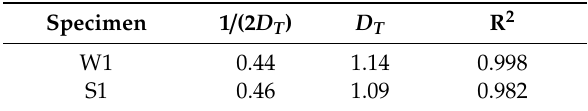
Figure 5. Schematic of the method for measuring the wetting front in the specimens: ( a ) Location of monitoring line L1 and typical transmission image of net water imbibition in W1 at 589.26 s; ( b ) Location of monitoring line L2 and typical transmission image of net water imbibition in S1 at 1230.00 s.